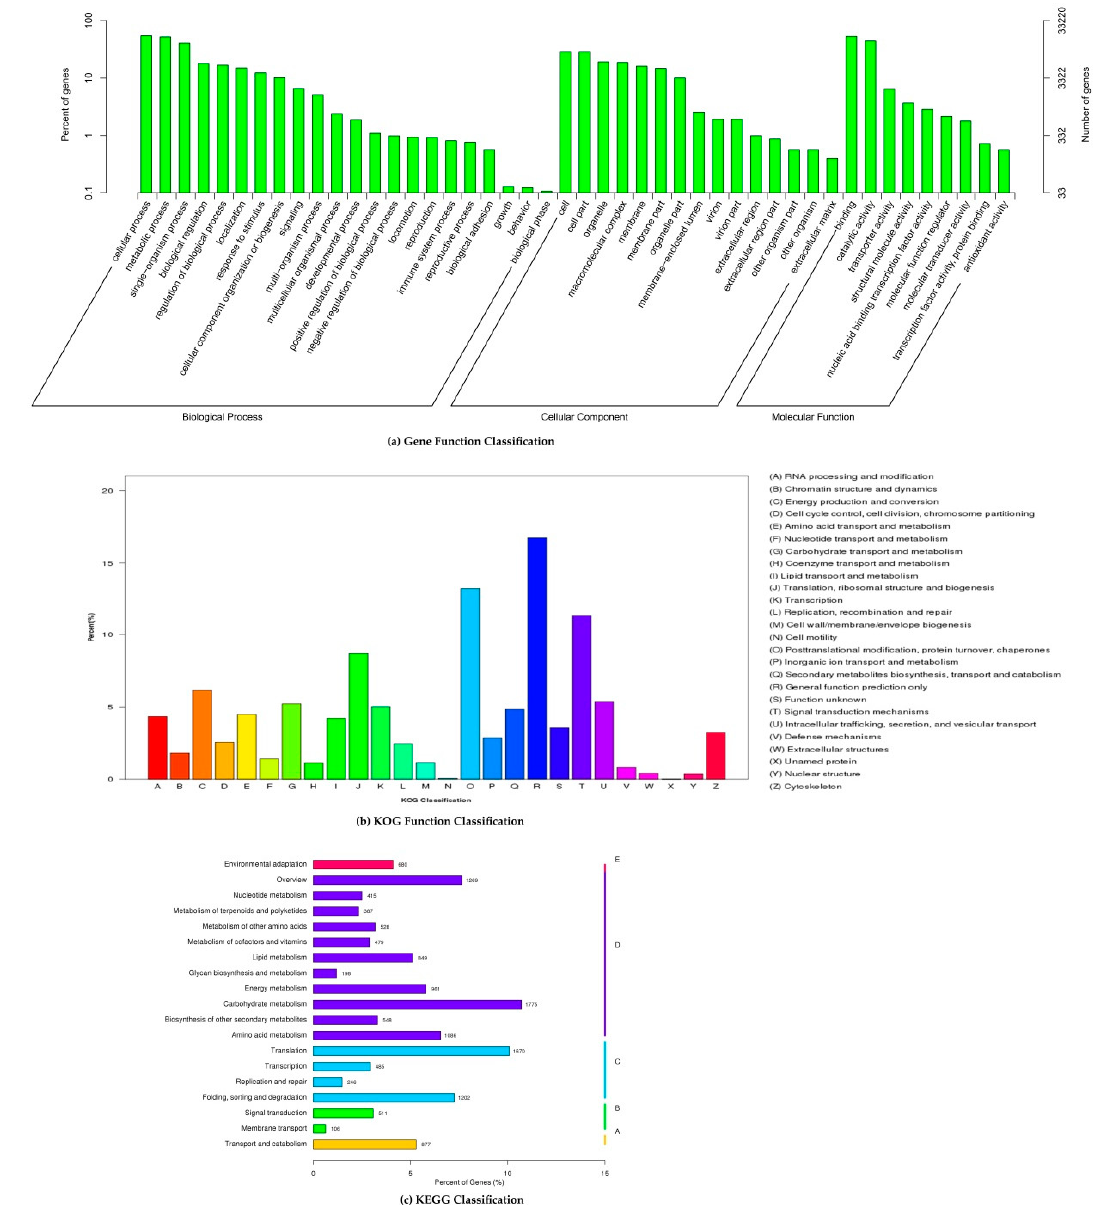
Figure 2. Functional classifications of D. odorifera unigenes. ( a ) Gene ontology (GO) classification of assembled unigenes. The left y -axis indicates the percentage of a specific category of genes in each main category. The right y -axis represents the amount of unigenes in a category; ( b ) Eukaryotic ortholog groups (KOG) classification of assembled unigenes. The y -axis indicates the amount of unigenes in a specific functional cluster. The x -axis shows function class; ( c ) Kyoto encyclopedia of genes and genomes (KEGG) classification of assembled unigenes. The y -axis indicates the KEGG pathway, and the x -axis is the ratio of the number of unigenes.